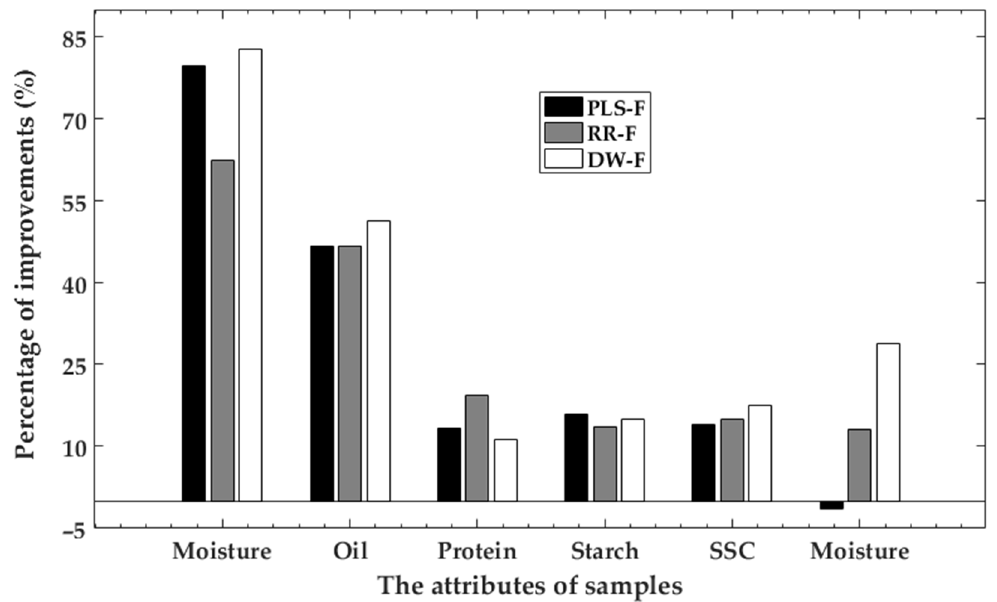
Figure 7. Percentages of improvements for RMSEP of three fusion models compared to the optimal PLS model in three spectral datasets.